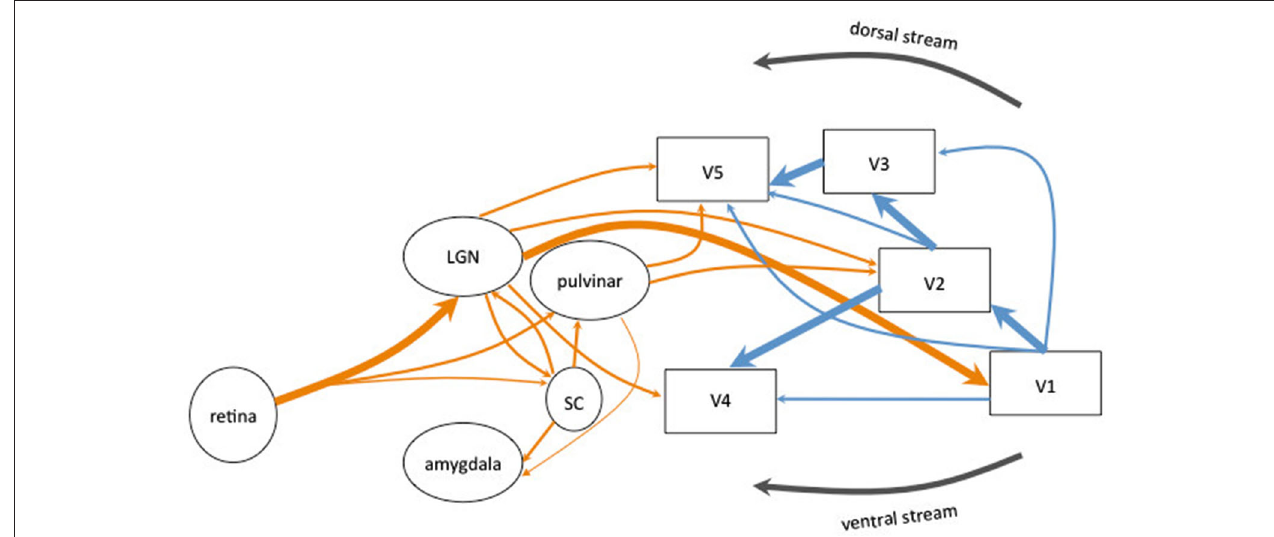
bypassing both V1 and the LGN. This pathway has been accounted to mediate action blindsight. Another colliculo-pulvinar pathway, associated with the ventral visual stream, synapses in the LGN and projects to extrastriate areas (in particular area V4) bypassing V1. This pathway has been accounted to mediate color and shape residual discrimination. Other collicular pathways are represented: the colliculo-pulvinar pathway (between SC and pulvinar), the pulvino-amygdalar pathway (between the pulvinar and amygdala) and the colliculo-pulvino-amygdalar pathway (between the SC, the pulvinar and the amygdala). These pathways have been accounted to mediate affective